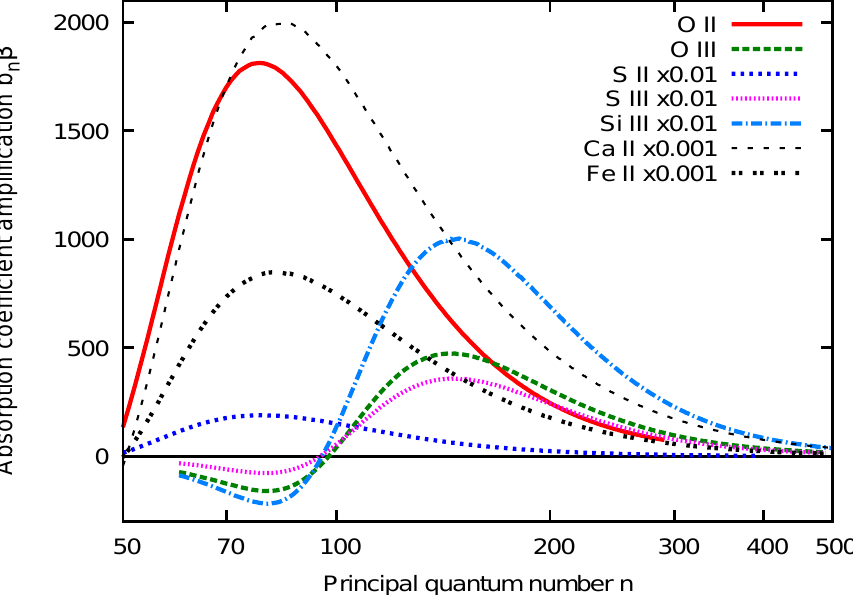
Fig. 2. Absorption coefficient amplification for the b n ’s shown in Figure